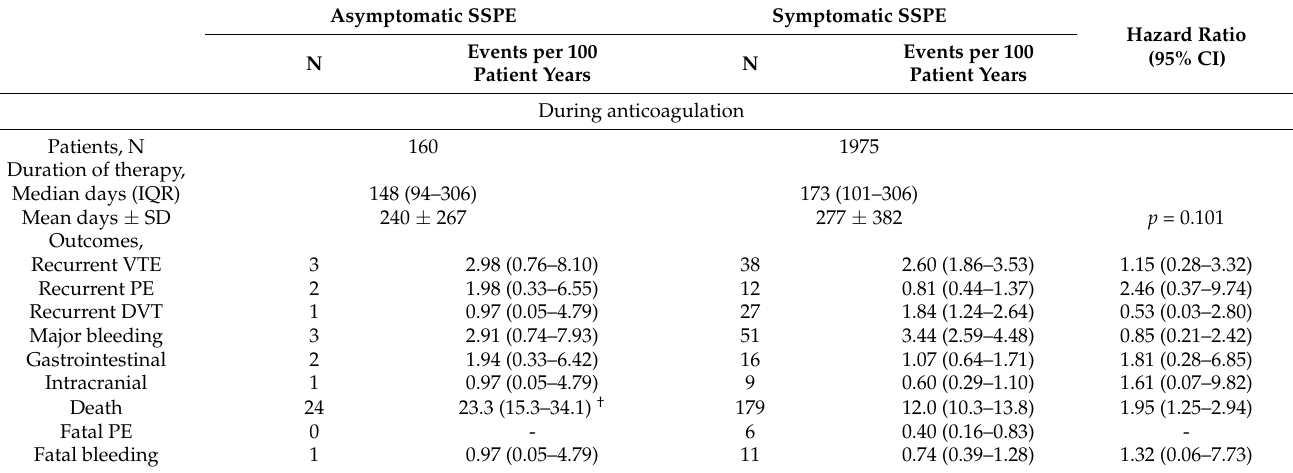
Table 3. Clinical outcomes during the course of anticoagulant therapy and after its discontinuation. Asymptomatic